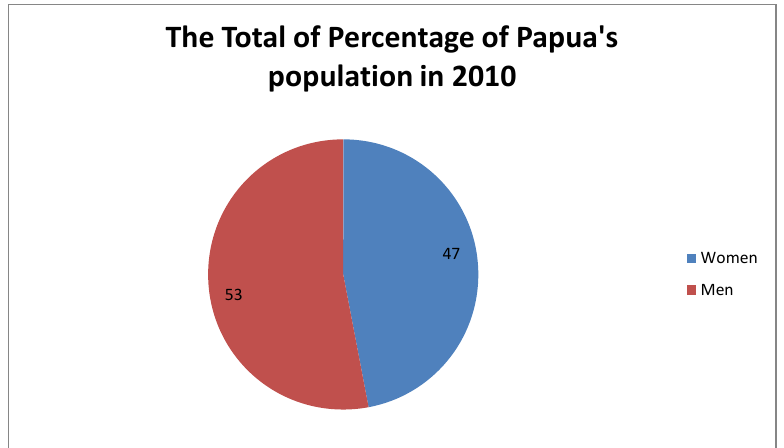
Percentage of Total Population in Prov. Papua Th. 2012. (Source: http://sp2010.bps.go.id/files/ebook/9400.pdf,